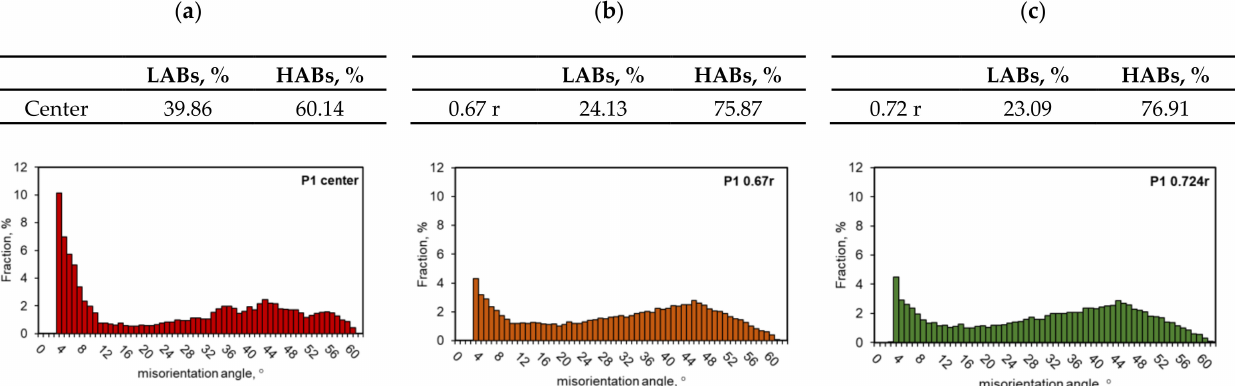
Figure 25. Changes in disorientation angles after hot torsion: ( a ) sample centre, ( b ) at a distance from the centre of 0.67 r and ( c ) at a distance from the centre of 0.72